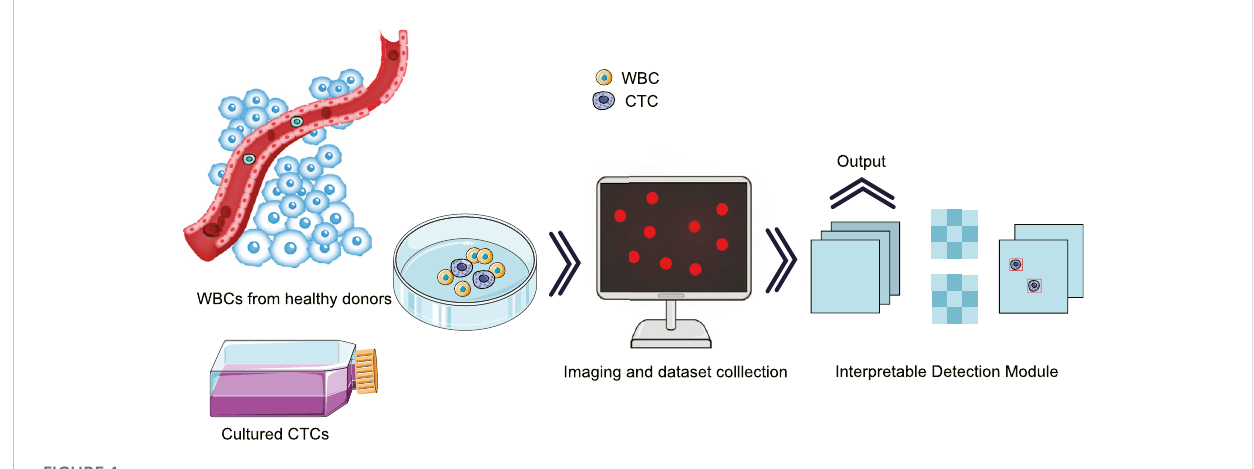
FIGURE 1 Schematic illustration for the interpretatively automated identi fi cation of CTCs in spiked samples, where CTCs were added in human peripheral blood containing